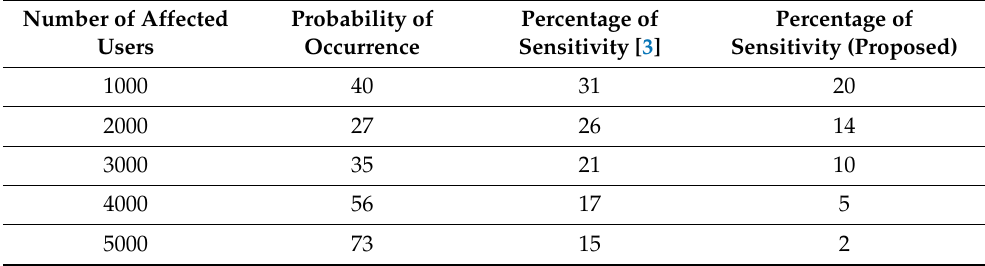
Table 6. Percentage of sensitivity.